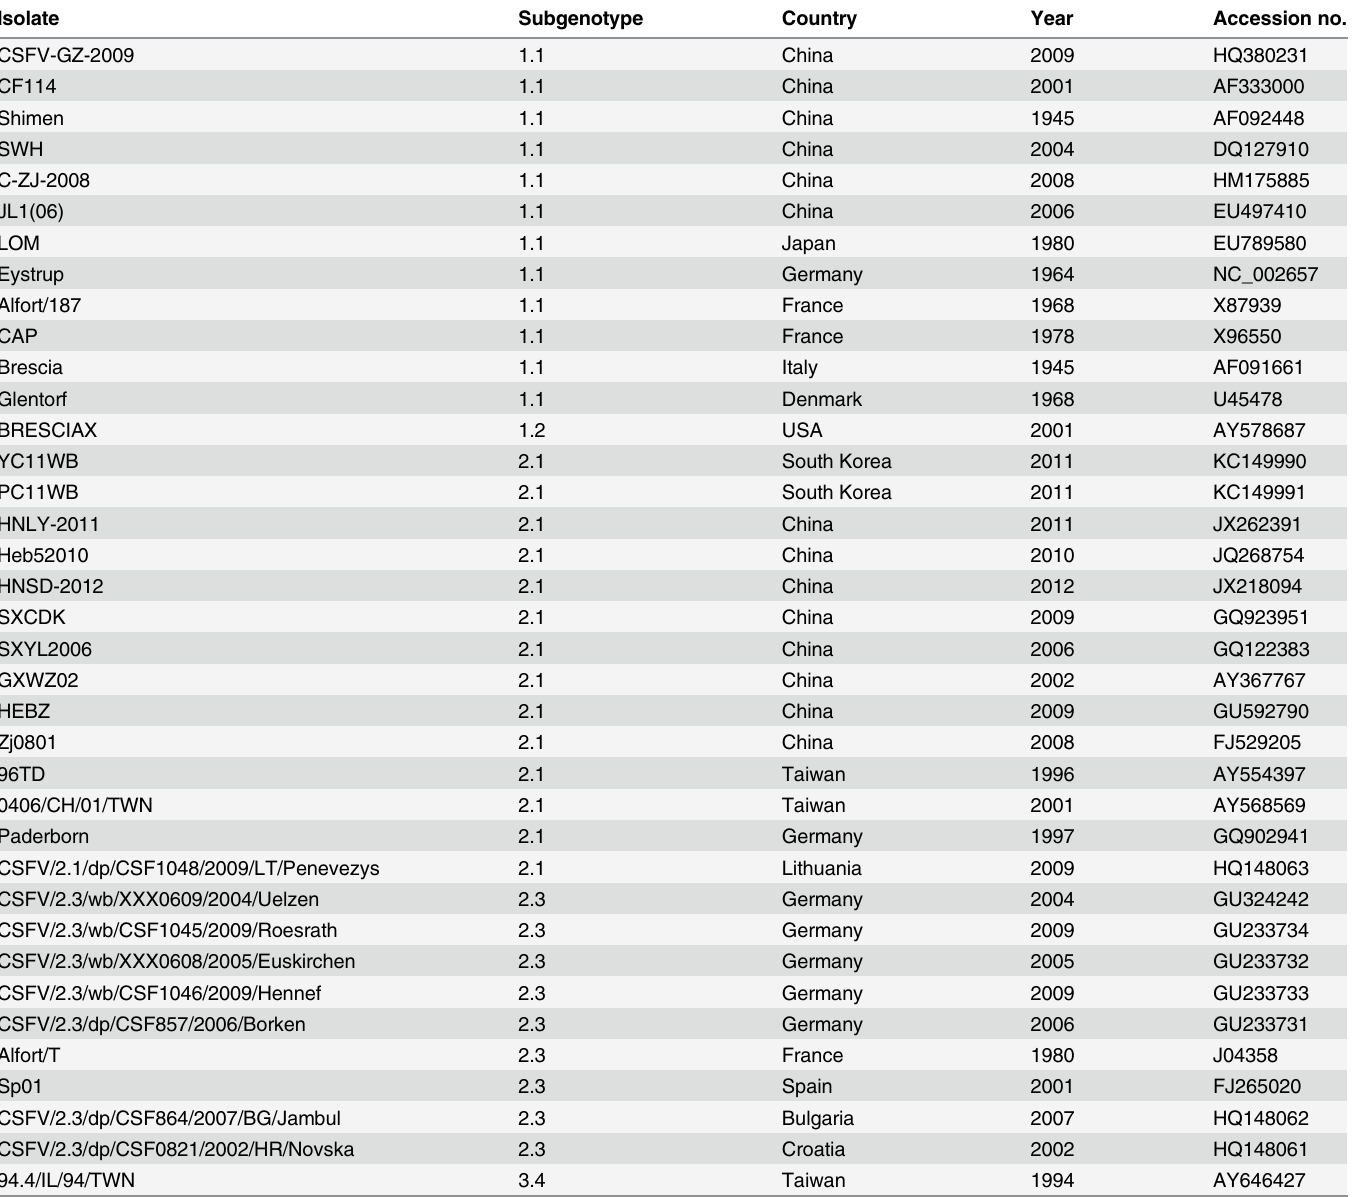
Table 1. Information of the isolates used in this